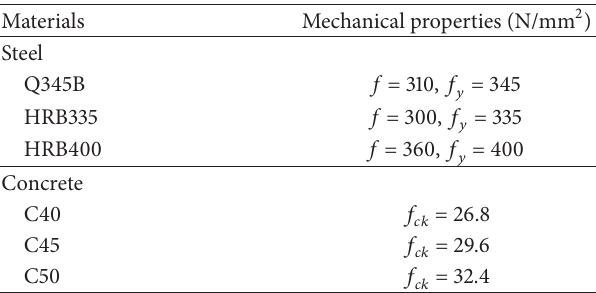
Table 2: Mechanical properties of materials used in museum prototype